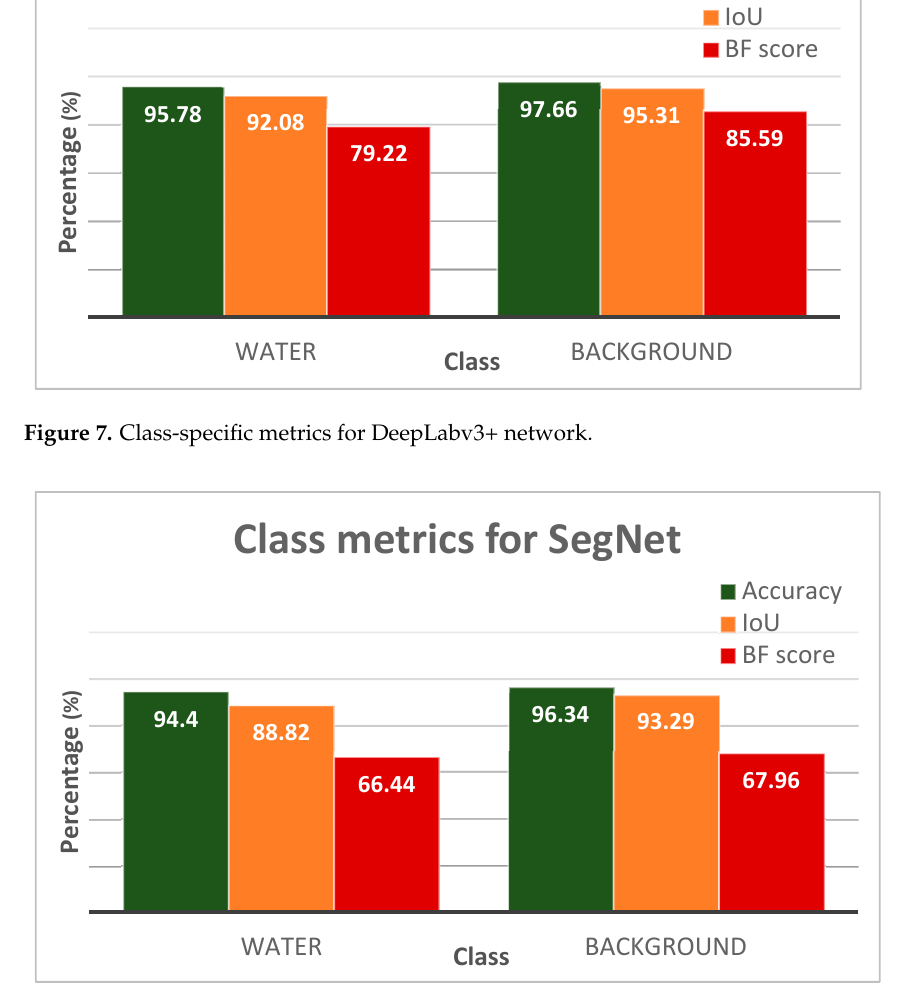
Figure 8. Class-specific metrics for SegNet network.